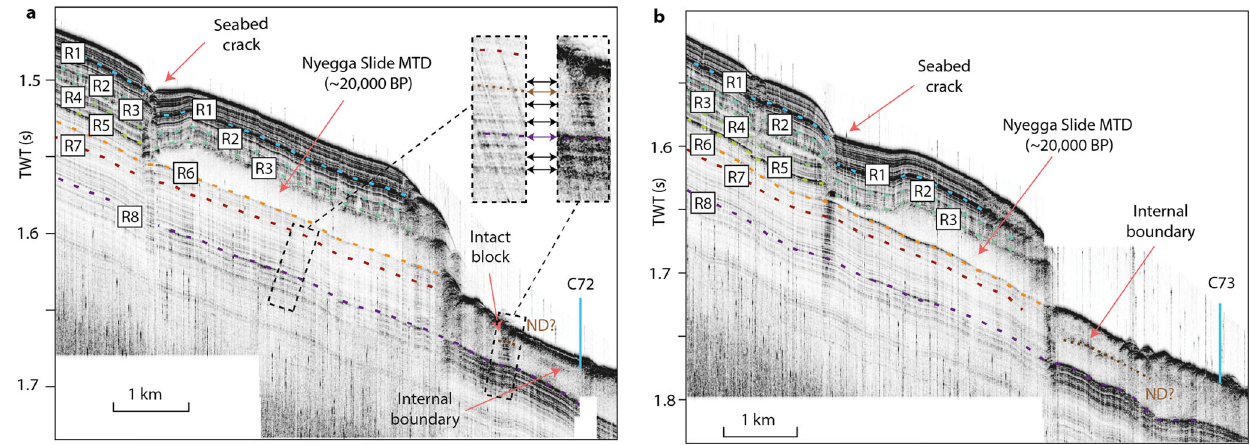
Fig. 3 Echosounder pro fi les from the sidewall of the Storegga Slide Complex. a and b Interpreted echosounder pro fi les crossing the northern Storegga Slide sidewall. R1 to R7 indicate the key re fl ections of the chrono-stratigraphic framework from Fig. 2a. The pro fi les show a partly buried ~ 20,000 BP Nyegga Slide MTD, the projected sediment core locations, and the slide scar in fi ll with indications for an internal boundary (Nyegga discontinuity, marked with ND), and the key horizons R1 to R8. Enlargements show a comparison between the stratigraphy of the sidewall and an intact